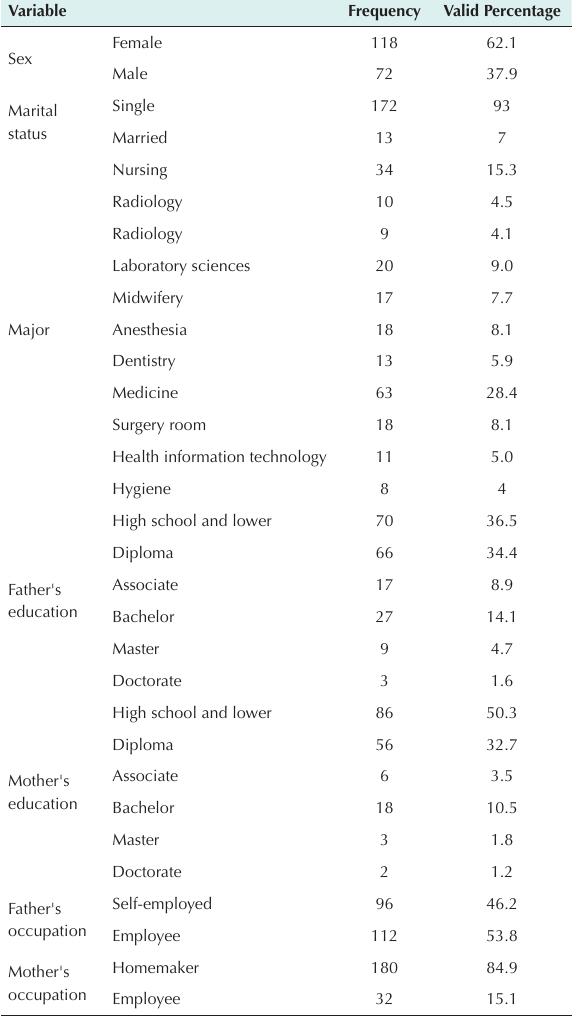
Table 1. Description of Demographic Variables of